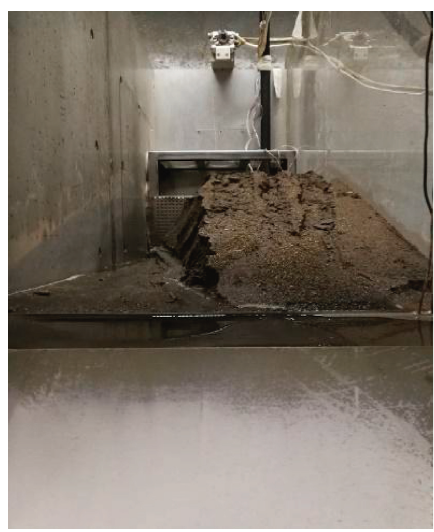
Figure 6: The shape of final breach.